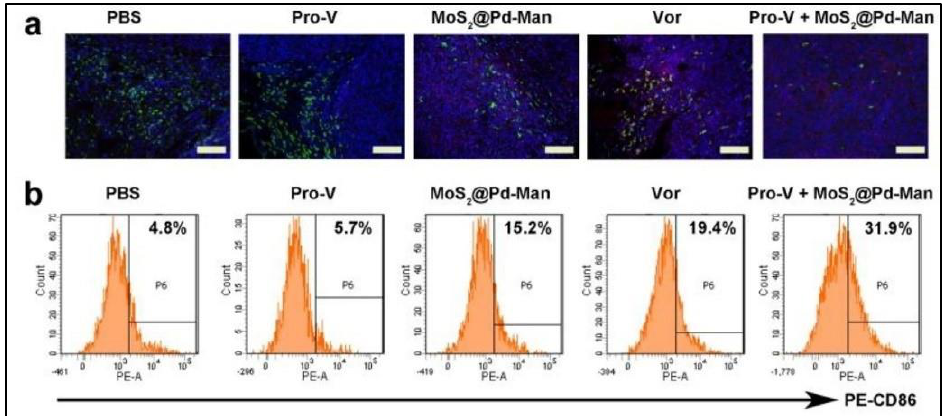
Figure 8. In vivo reprogramming of TME: ( a ) immunofluorescence images showing the tumor-dis- tribution of M1 and M2 macrophages (red: M1U; green: M2U); Scale bars: 100 m; ( b ) flow cytome- try analysis of the expression levels of CD86 in F4/80+ macrophages within the tumor tissuesPE- CD86: anti CD-86 antibody; various study groups: PBS (control); Vor (vorinostat); Pro-v (vorinostat prodrug); MoS 2 @Pd-Man (mannose vector decorated palladium bio-orthogonal nanozyme); and Pro-V + MoS 2 @Pd-Man. Reprinted with permission from Ref. [94]. Copyright 2022 Elsevier.